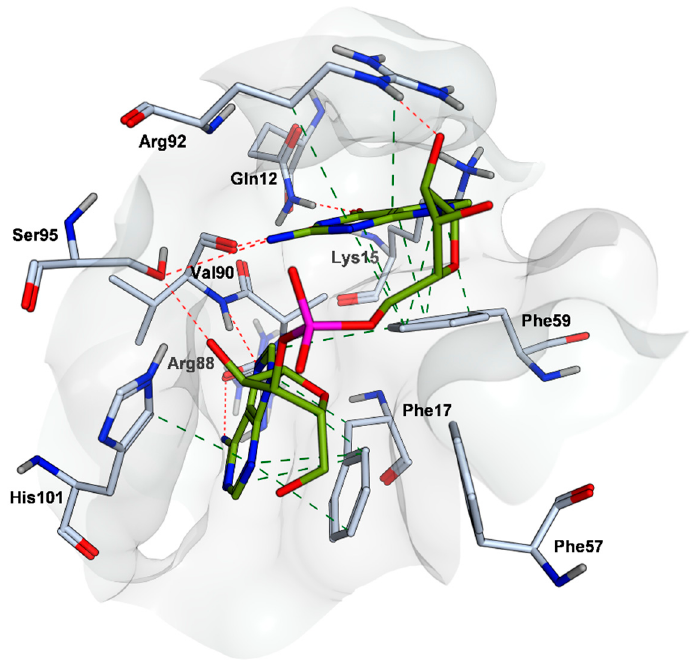
Figure 2. hnRNP A1 interactions with 5 ′ -AG-3 ′ RNA recognition sequence within the pocket. Hydrogen-bonding interactions formed between the nucleobases with the backbone and side chains of Val90, Arg88, Gln12 residues, as well as those formed by the sugars of the RNA backbone with side chains of Arg92 and Ser95 are indicated with red dashed lines. Hydrophobic interactions with Phe17, His101, Phe59 and aliphatic side chains are indicated with dashed green lines. Inhibitors targeting the pocket are expected to block UP1 binding to RNA and alter hnRNP A1 splicing activity.